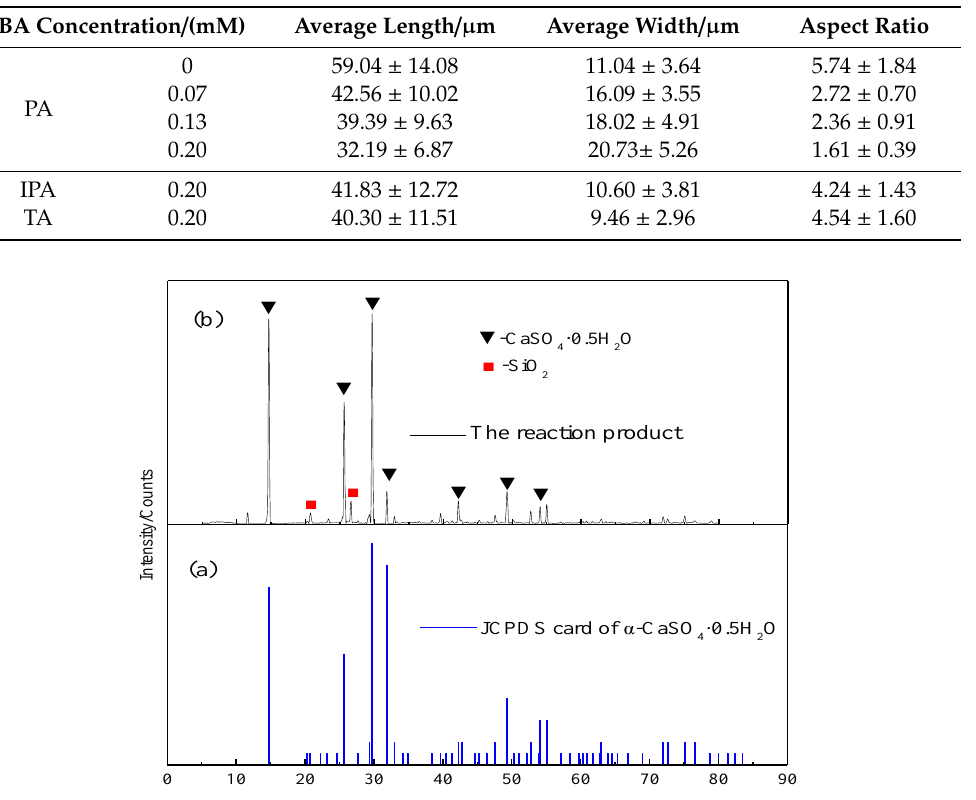
Figure 3. XRD patterns of ( a ) the JCPDS card of α-CaSO 4 ·0.5H 2 O and ( b ) the reaction product prepared without organic acid.